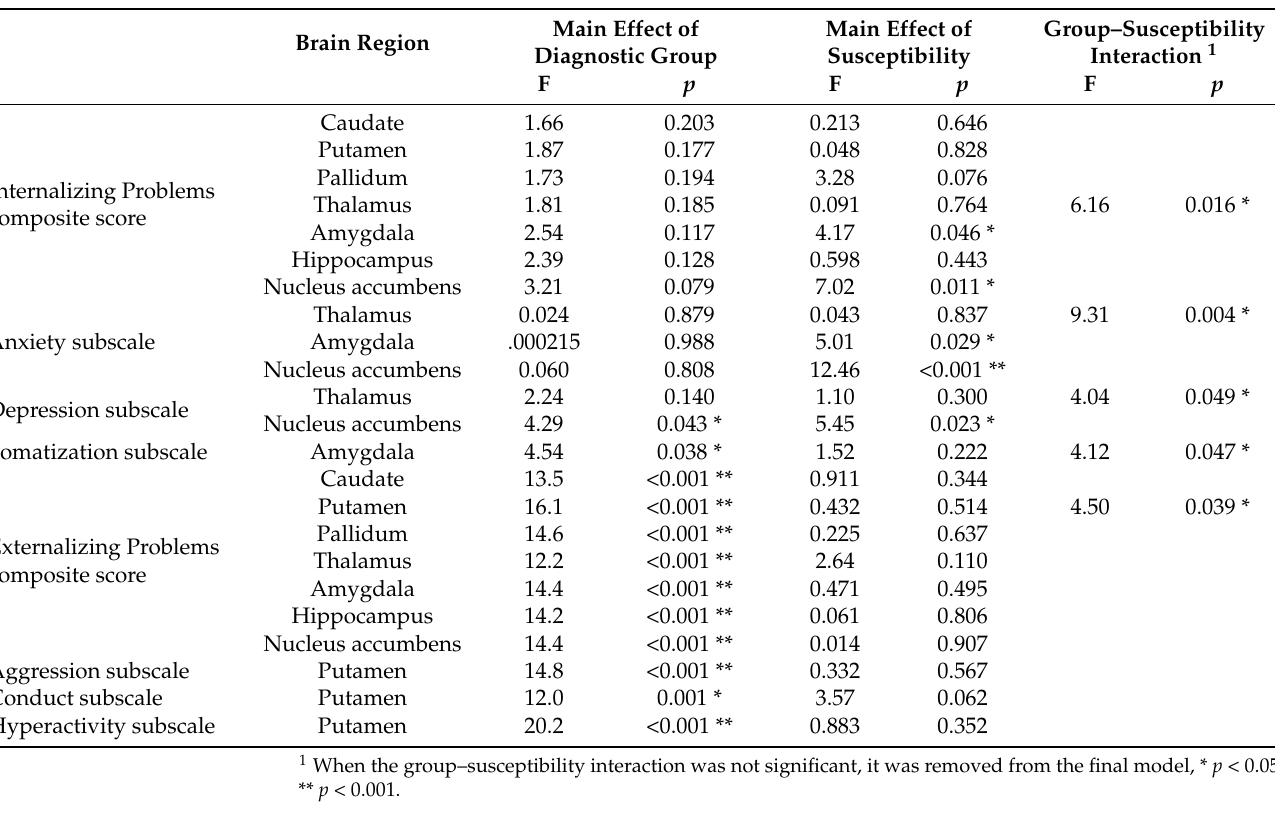
Figure 3. Amygdala magnetic susceptibility was positively associated with Internalizing Problems and Anxiety symptoms in youth with and without PAE. Group – susceptibility interactions showed higher susceptibility was associated with more Somatization symptoms in youth with PAE and fewer Somatization symptoms in unexposed youth, although associations were not significant within each group. Susceptibility values are corrected for age and gender. p values indicate the main effect of susceptibility on Internalizing Problems and Anxiety and the group – susceptibility interac- tion for Somatization. Dashed lines indicate non-significant associations within a group. There was a group – susceptibility interaction for the thalamus for Internalizing T scores ( F (1, 53) = 6.157, p = 0.016, q = 0.056; Table 5), Anxiety ( F (1, 53) = 9.305, p = 0.004, q = 0.006), and Depression ( F (1, 53) = 4.043, p = 0.049, q = 0.074), such that scores were more negatively correlated with susceptibility for the PAE group than controls (Figure 4). Only the relationship for the Anxiety subscale survived multiple comparison correction.